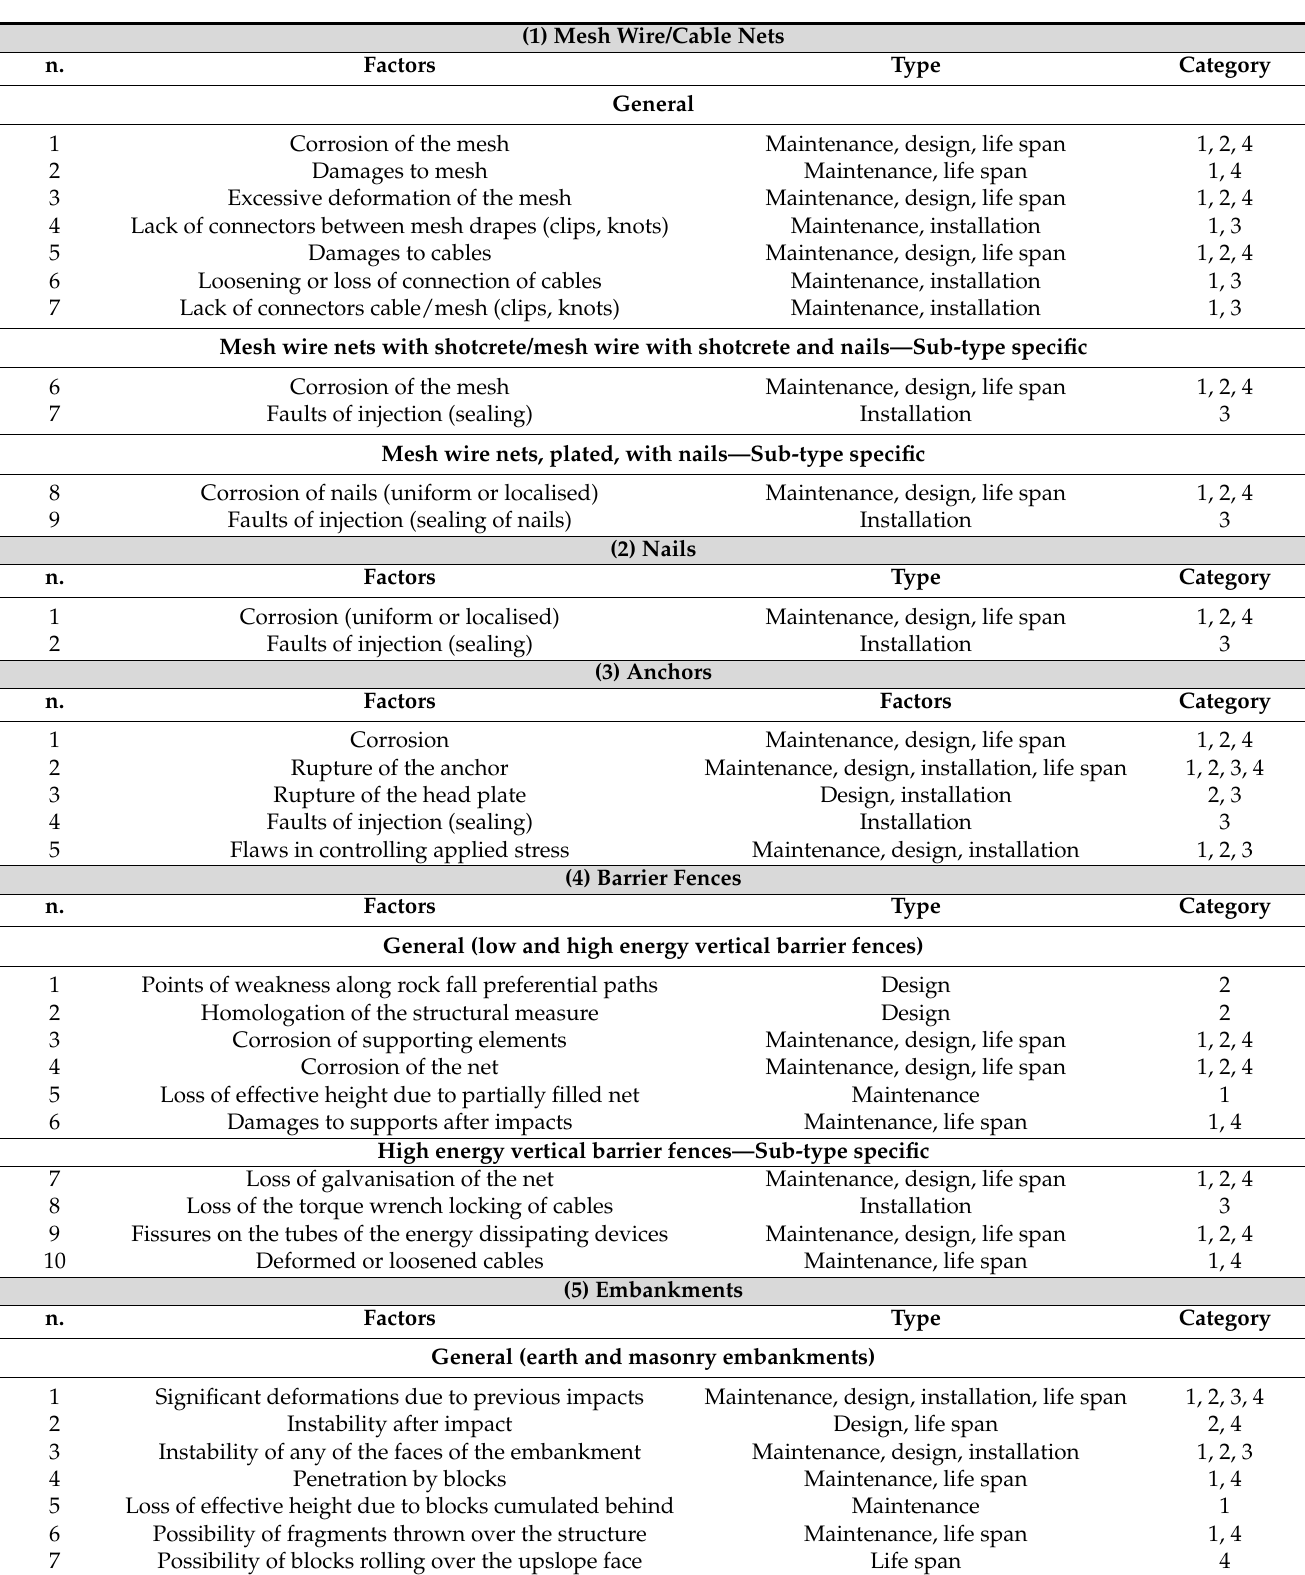
Table 2. List of factors potentially degrading the performance of rock fall protection measures—Group N (factors specific to each type of protection